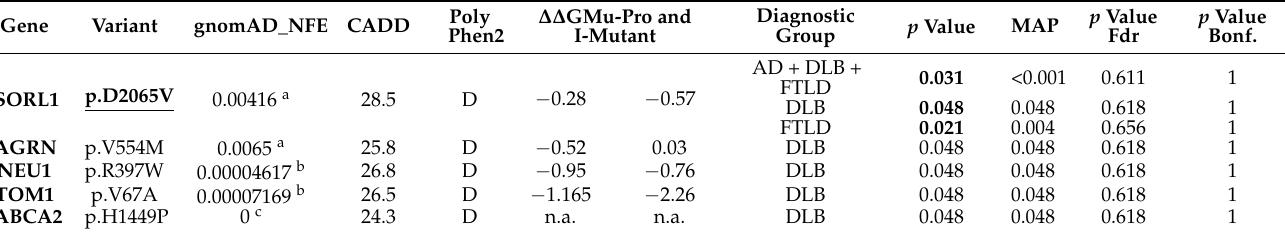
Table 5. Single variant